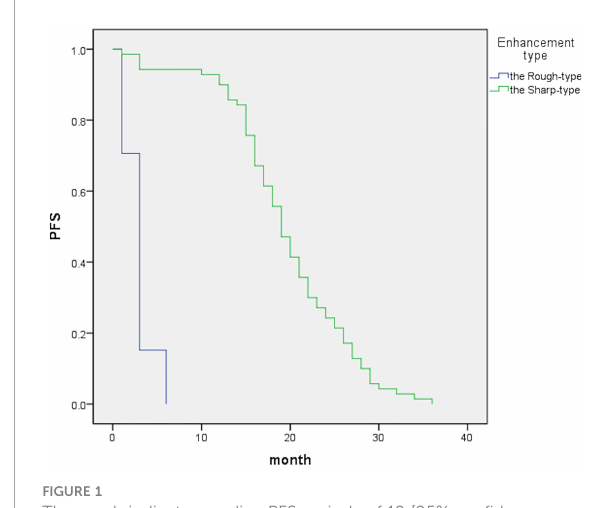
FIGURE 1 The graph indicates median PFS periods of 19 [95% con fi dence interval (CI), 17.4 – 20.6] and 3 (95% CI, 2.7 – 3.3) months for the sharp- and rough-type groups,